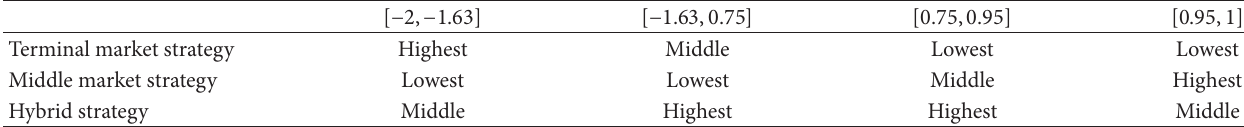
Table 10: Performance in the different strategies when the working capital ratio is in different